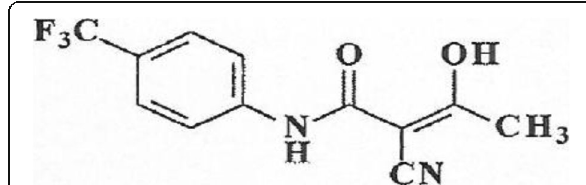
Fig. 1 Chemical structure of teriflunomide